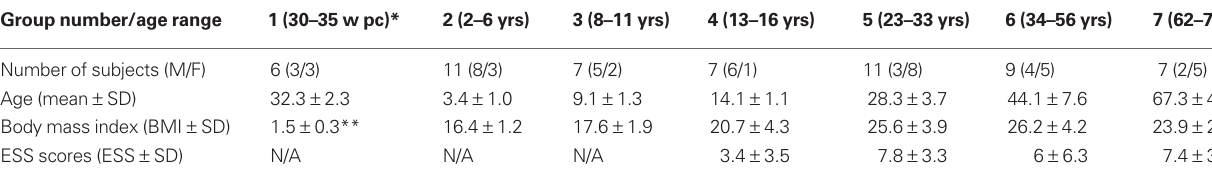
Table 1 | Participant characteristics.